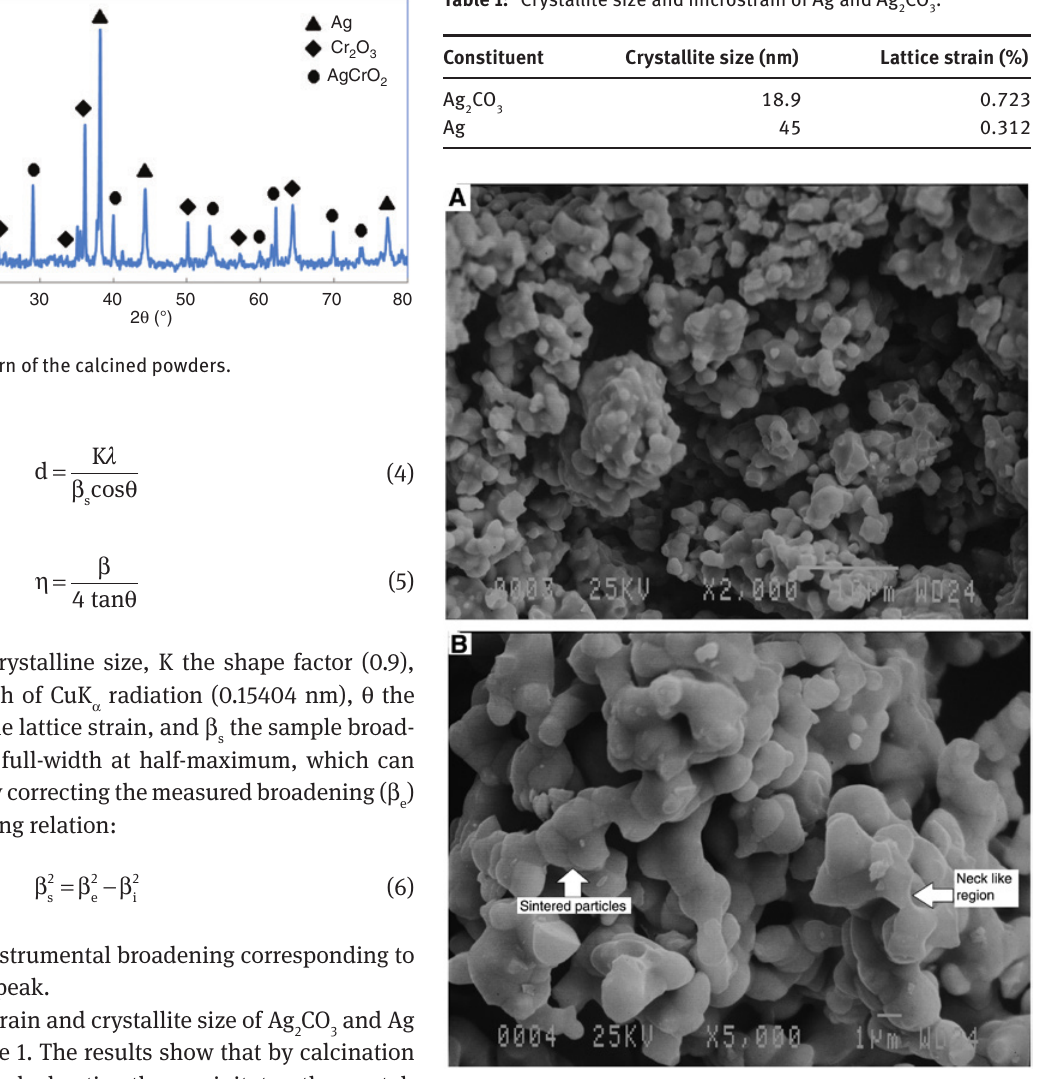
Figure 5: Microstructure of the calcined particles: (A and B) SEM image of the calcined powders in two magnifications. The sintered particles and neck-like regions are shown by arrows.